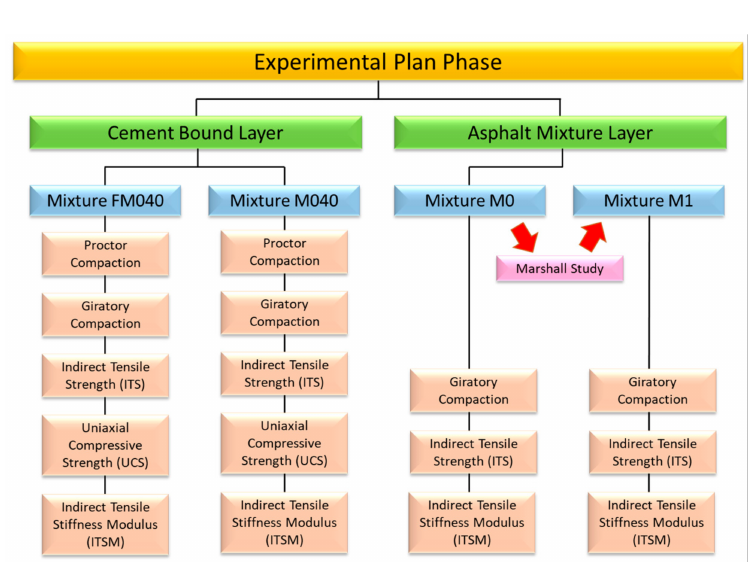
Figure 3. Experimental